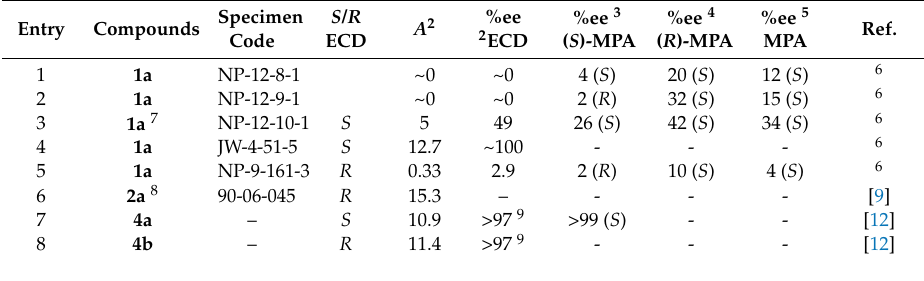
Table 1. Optical Purities of N , O -Dibenzoyl Derivatives of 1a 1 – 3a by ECD and CDA Methods.